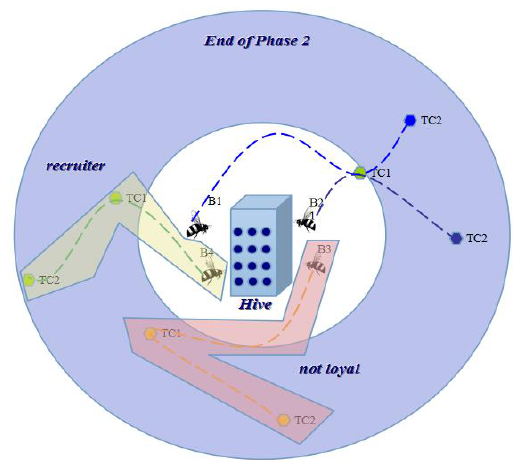
Figure 3. The backward phase of our BCO